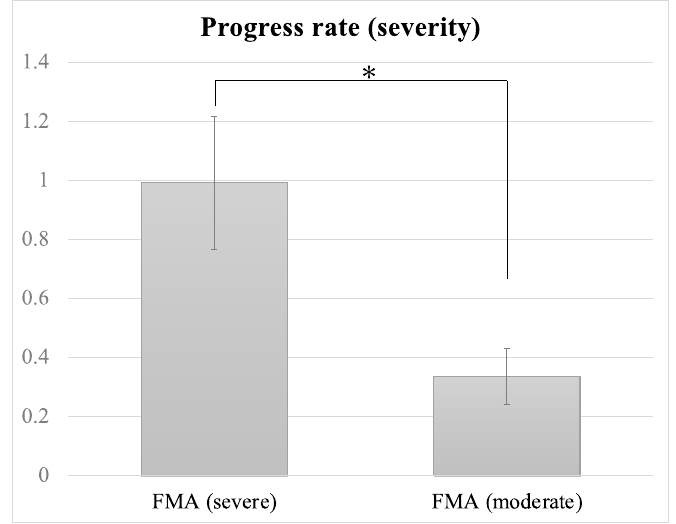
Figure 3. Progress rates of patients with severe and moderate paresis. Error bars indicate standard errors. Significant difference is denoted by *; FMA: Fugl-Meyer motor assessment scale for upper extremity.